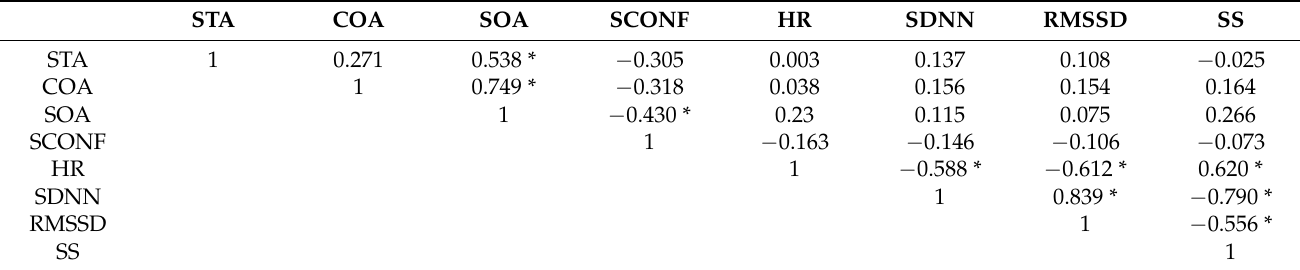
Table 2. Correlation between anxiety variables and heart rate variability variables.